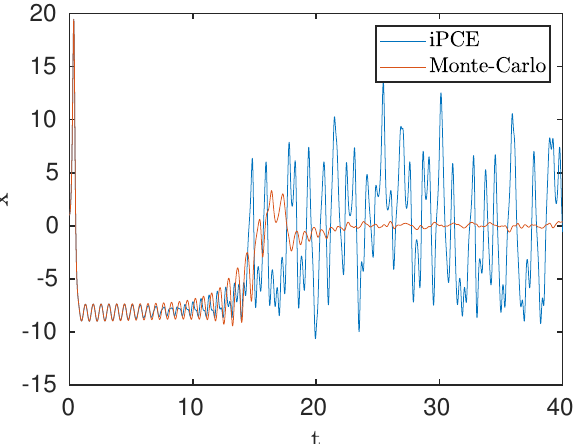
Figure 1. Comparison of the mean value of x coordinate of the trajectory, as computed by intrusive Polynomial Chaos (iPC) and Monte–Carlo (MC) with N = 5000 samples. Uncertainty is introduced through β = β 0 + β 1 ξ , where ξ ∼ N ( 0,1 )